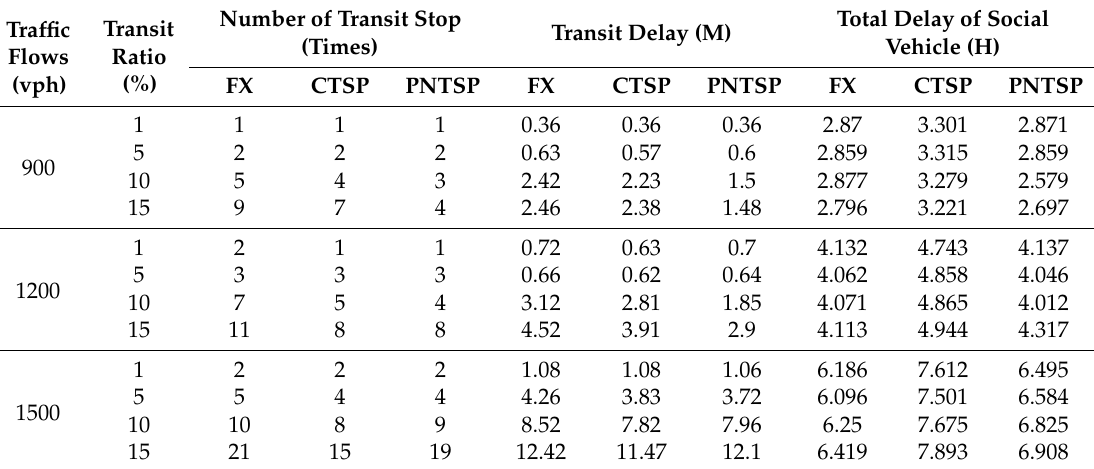
Table 5. Statistics of simulations in